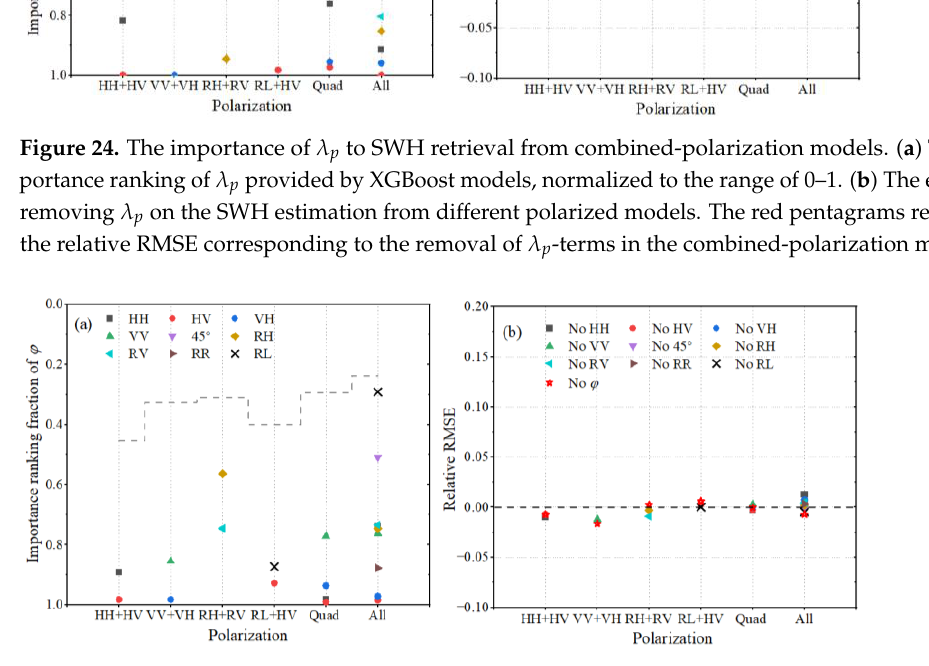
Figure 25. The importance of φ to SWH retrieval from combined-polarization models. ( a ) The importance ranking of φ provided by XGBoost models, normalized to the range of 0 – 1. ( b ) The effect of removing φ on the SWH estimation from different polarized models. The red pentagrams represent the relative RMSE corresponding to the removal of φ -terms in the combined-polarization models.